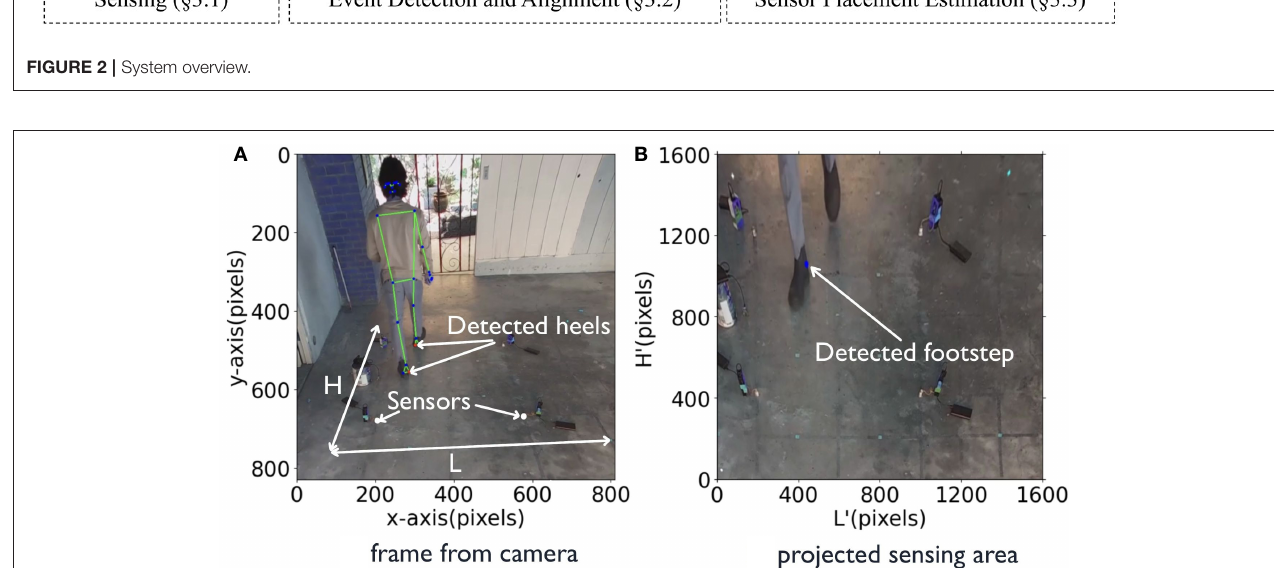
FIGURE 3 | Pedestrian posture estimation for footstep event detection (A) BlazePose outputs keypoints of human posture marked in blue dots. The red dot marks the detected heel keypoints. AutoLoc tracks the heel keypoints for footstep detection. (B) Sensing area H’ × L’ in the floor coordinate projected from H × L in the camera view (A)